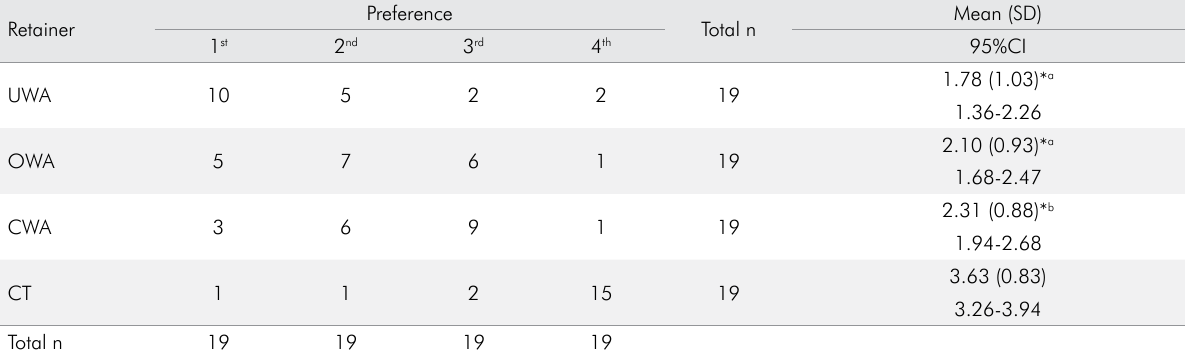
Table 2. Users’ preference of retainers from the best (1 st ) to the worst (4 th ). Retainer